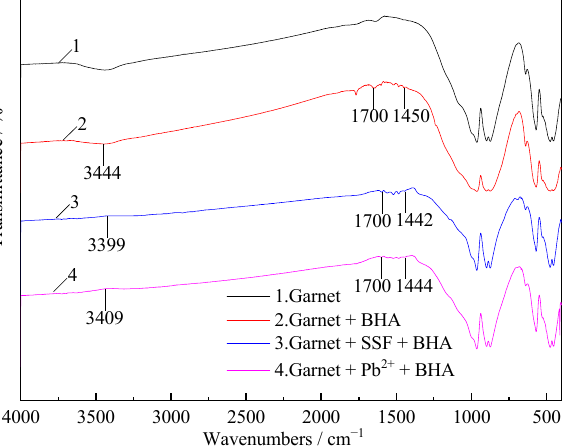
Figure 13. Infrared spectra of garnet before and after the interaction with